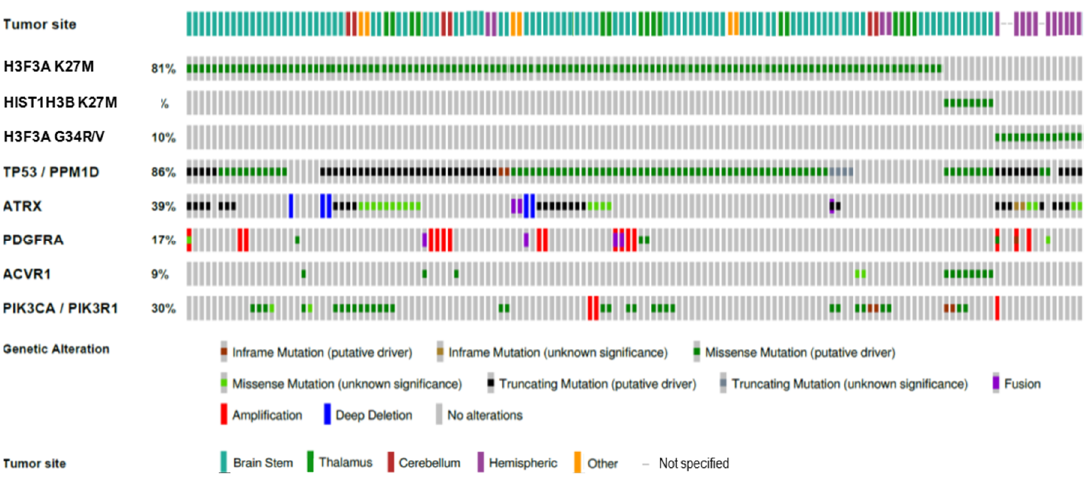
Figure 1. Oncoprint depicting tumor locations and selected typical genetic alterations in histone-mutant pHGG. Original data publicly available in PedcBioPortal.